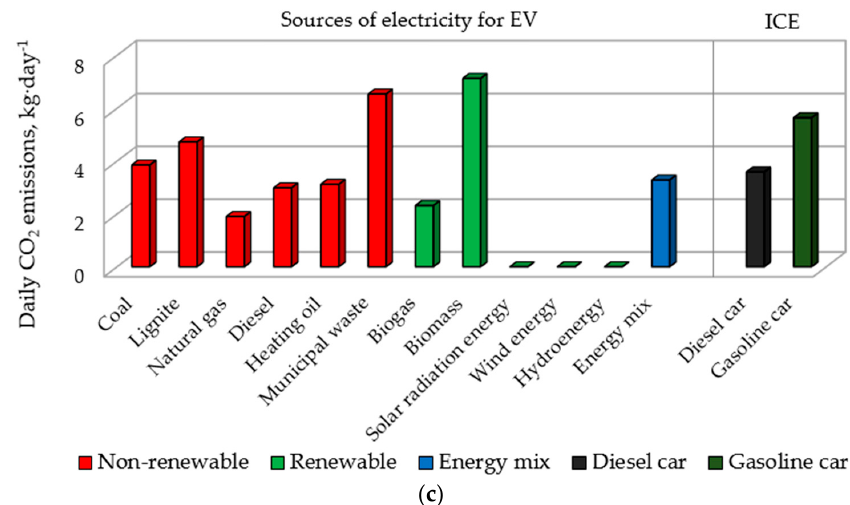
Figure 5. Comparison of daily indirect carbon dioxide emissions to the atmosphere generated by an electric car and direct emissions generated by a conventional car (distance of 26 km): ( a ) city, ( b ) sedan, ( c ) SUV.